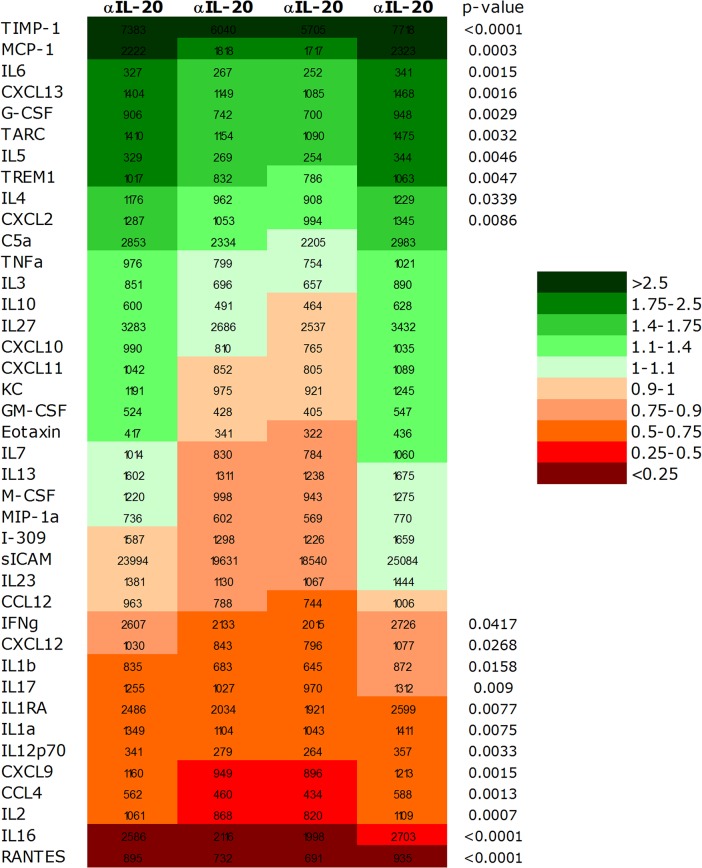
Heat map analysis and the relative expression of proteins in pancreas at the termination of the experiment.Heat map analysis showing the proteins up (green) and down (red) regulated by anti-IL20 treatment arranged in order of fold modulation (increased on top and decreased on bottom) compared for individual anti-IL20 antibody treated mice compared to vehicle treated mice. Four pancreatic tissues were evaluated in each group. Statistical evaluation is performed with 1-way ANOVA.